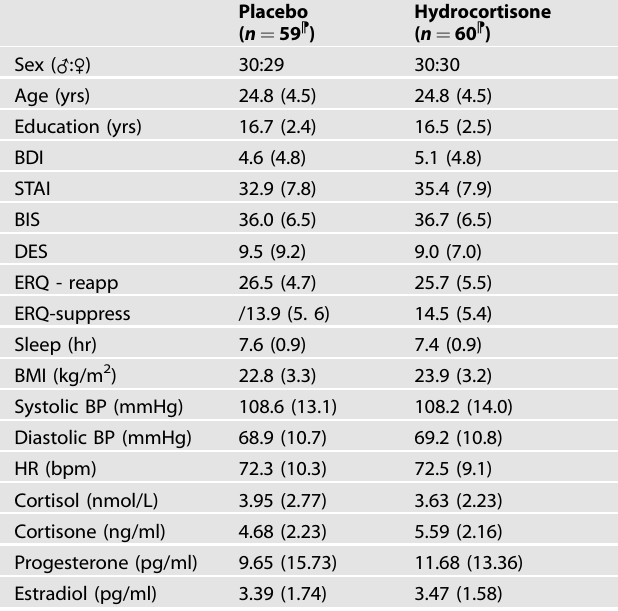
Table 1. Baseline participant characteristics.